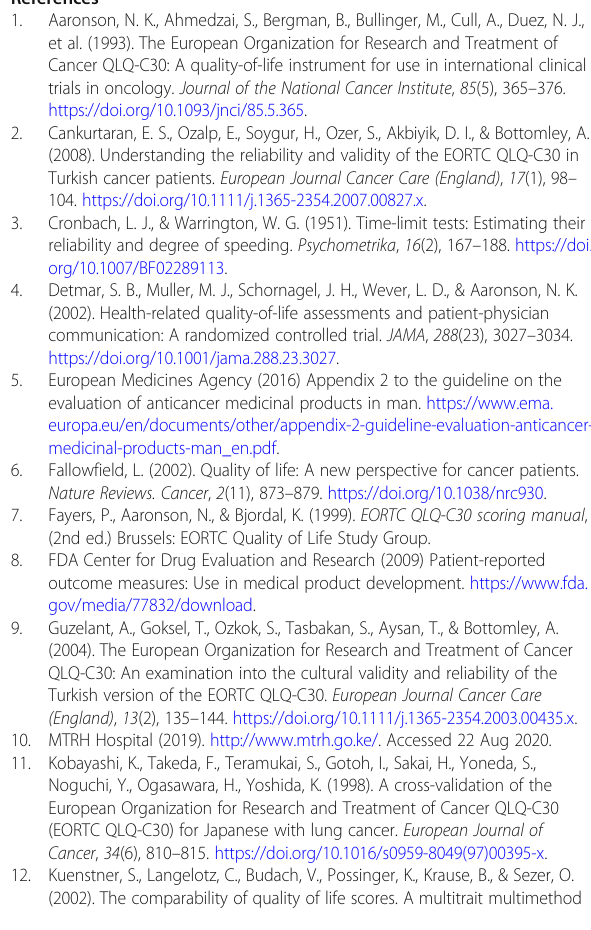
PF Physical functioning, RF Role functioning, FA Fatigue, PA